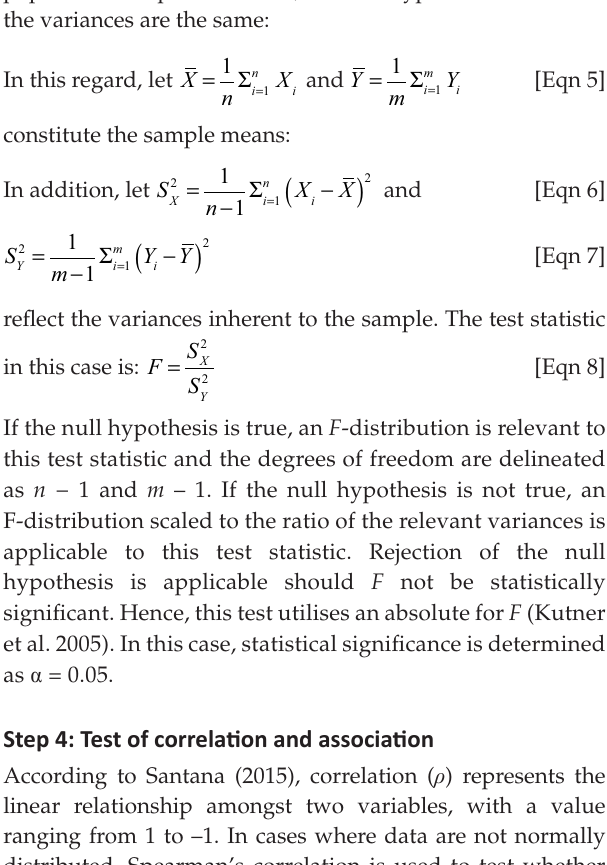
TABLE 2: Trade trends in sample countries and the Southern African Development Community.